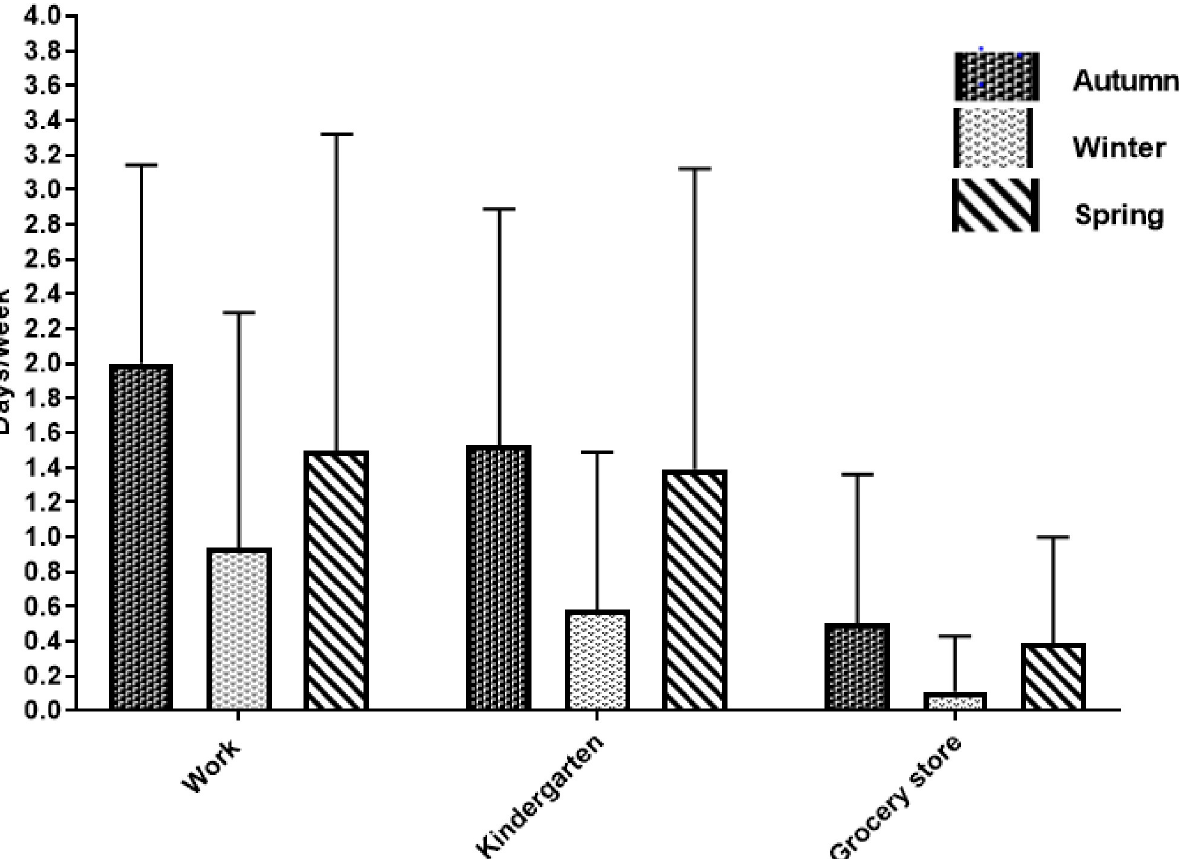
Fig 2. Change in cycling frequency. Change (mean (SD), days/week) in cycling frequency from baseline to follow-up in the intervention group (n = 18), grouped according to destinations (work, kindergarten, grocery store) for the autumn, winter and spring seasons respectively. Follow-up measures were conducted after 3, 6 and 9 months, i.e. following the autumn, winter and spring season.